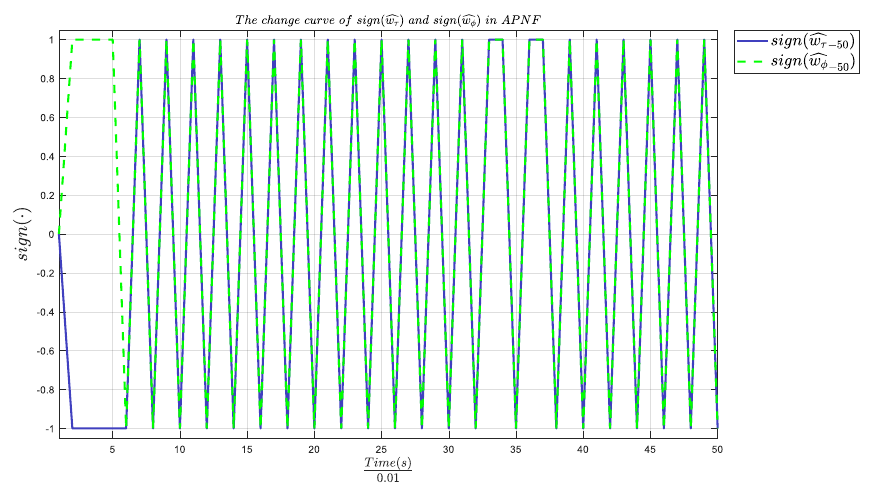
Figure 12. Parameter change curve of 𝑠𝑖𝑔𝑛(𝑤̂ 𝜏 ) and 𝑠𝑖𝑔𝑛(𝑤̂ 𝜙 ) within 0.5 s of APNF.